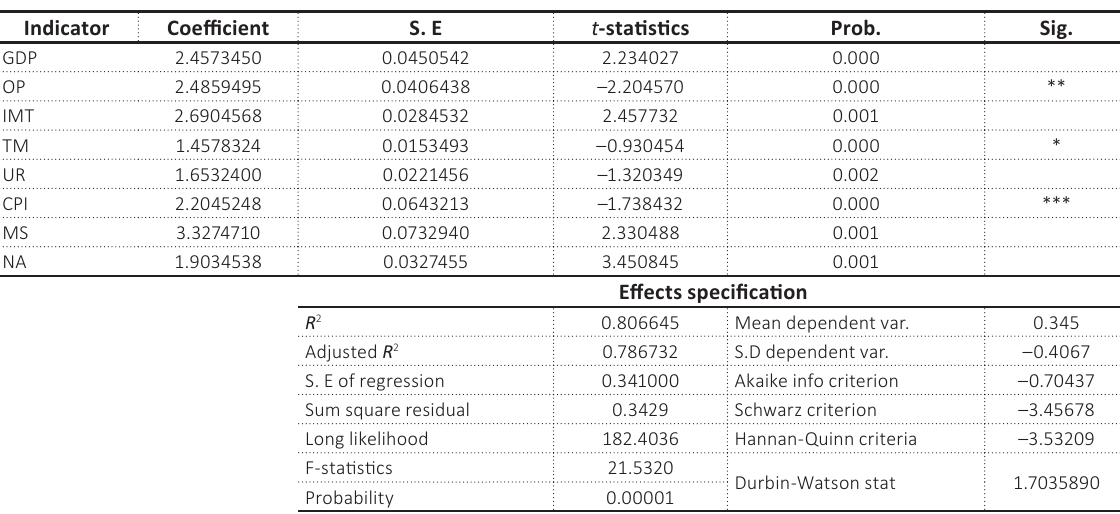
Table 7. Results of panel regression analysis (resilience